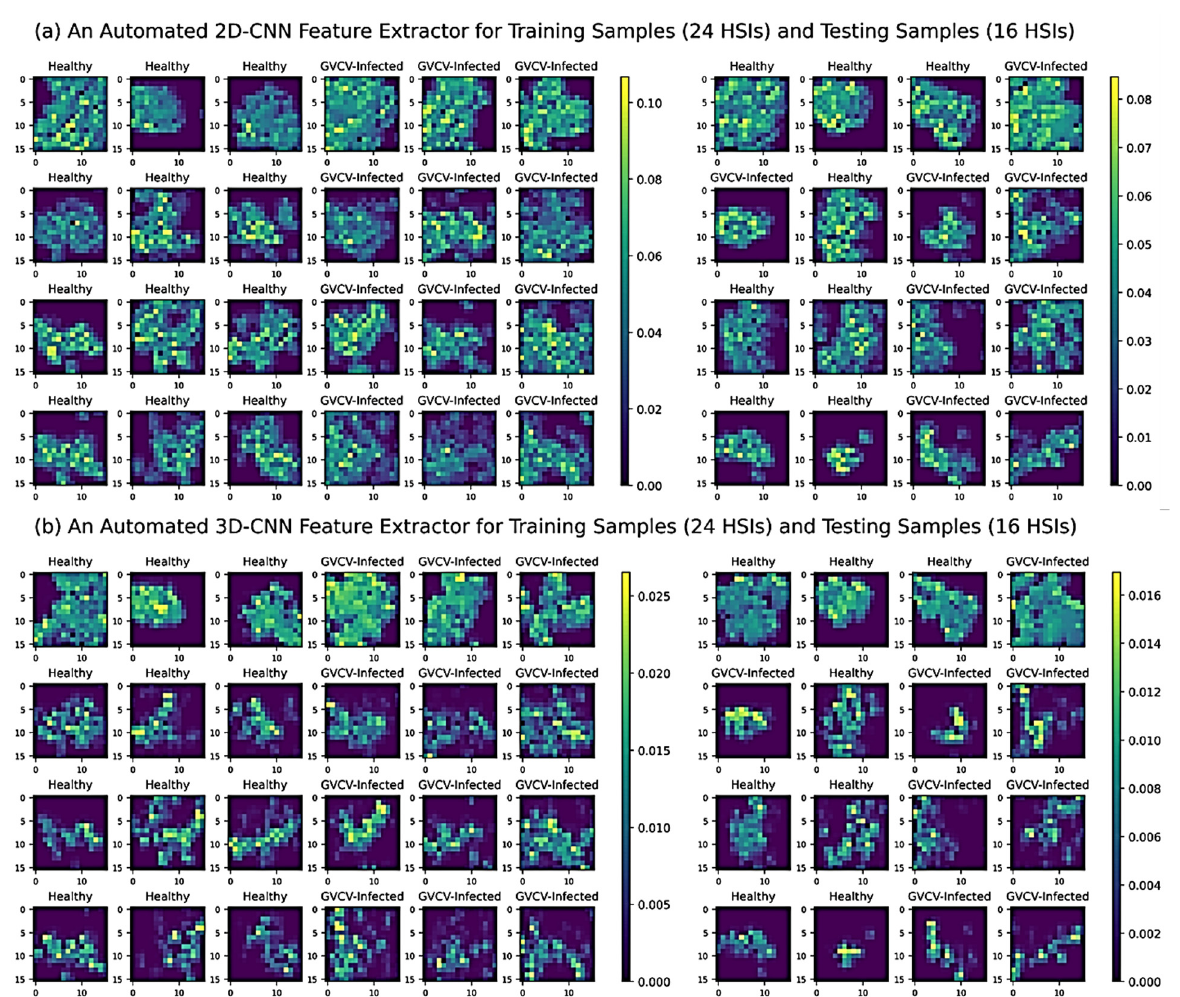
Figure 9. Convolutional filters and feature maps of an automated 2D-CNN feature extractor ( a ) and 3D-CNN feature extractor ( b ) for 24 training HSIs and 16 testing HSIs. From the original dimension 512 × 512 pixels × 203 bands (width × height × spectral bands), hyperspectral data cubes were reduced to a new and lower-dimensional data space of 16 × 16 pixels × 64 filters (width × height × convolutional filters) by the 2D-CNN feature extractor and 16 × 16 pixels × 5 bands × 64 filters (width × height × spectral bands × convolutional filters) by 3D-CNN feature extractor. The reduced spatial features (16 × 16) were plotted against the convolutional filter values (a random selection from 64 units). The graduated scale represents the convolutional values.